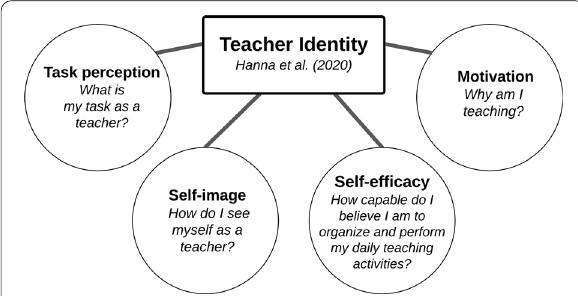
Fig. 1 Components of professional teacher identity (Hanna et